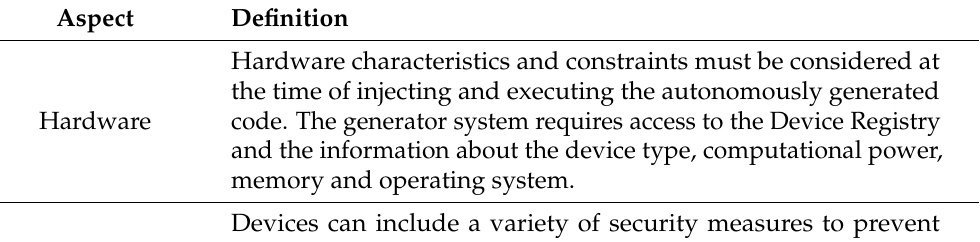
Table 1. Significant aspects of interface